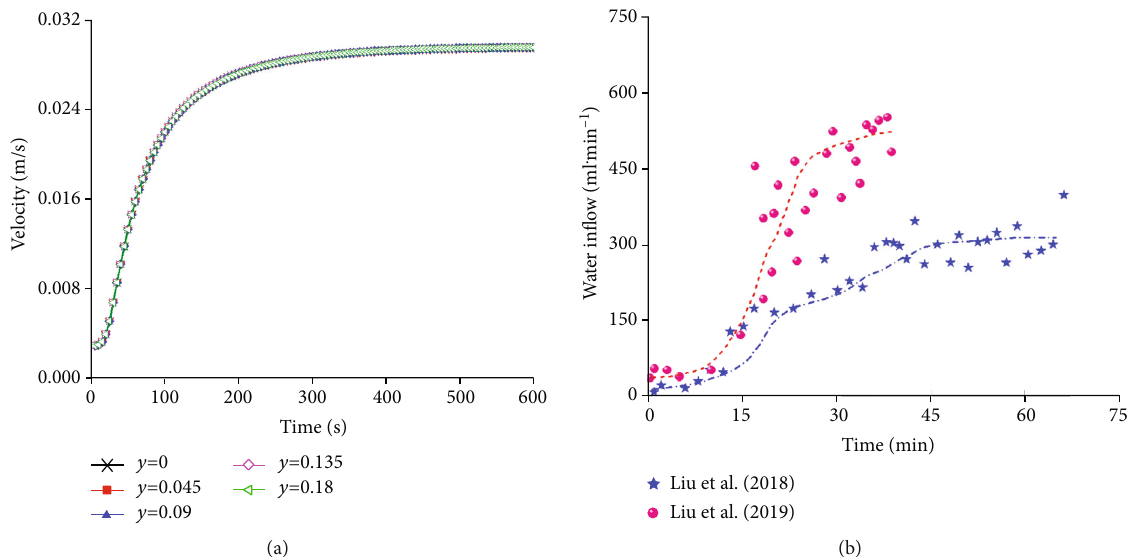
Figure 10: Evolution of fl ow velocity over time: (a) simulation results and (b) experimental results from